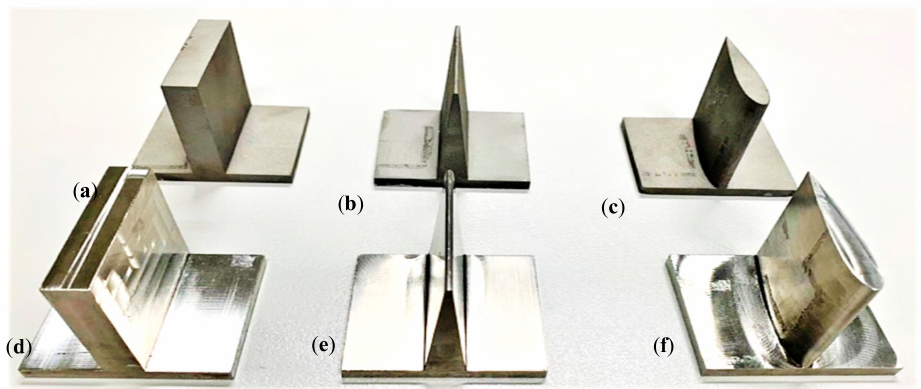
Figure 2. Test samples ( a ) AM–HX1; ( b ) AM–HX2; ( c ) AM–HX3; ( d ) CM–HX1; ( e ) CM–HX2; ( f )